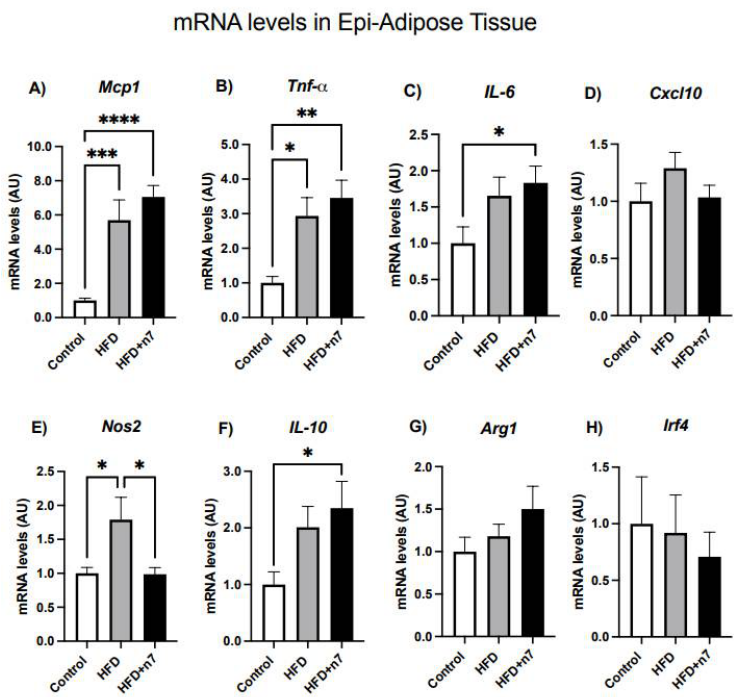
Figure 3. Effects of HFD and palmitoleic acid supplementation on mRNA levels of cytokines expressed by Epi-WAT. ( A ) Mcp1 , ( B ) Tnfa , ( C ) Il6 , ( D ) Cxcl10 , ( E ) Nos2 , ( F ) Il10 , ( G ) Arg1 , and ( H ) Irf4. Values of mRNA were expressed as arbitrary units (AU) in relation to the control and corrected by the expression of the constitutive gene Gapdh . Values are mean ± SEM (n = 12). * p < 0.05, ** p < 0.001, *** p < 0.0001 or **** p < 0.00001 vs. Control.